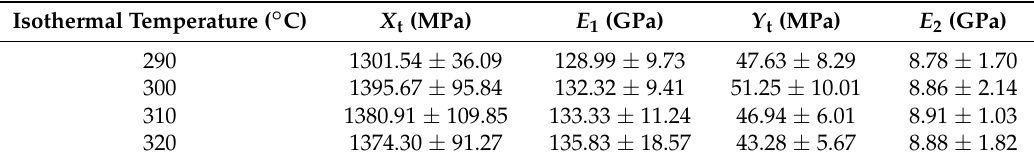
Table 1. Longitudinal and transverse tensile properties of CF/PEEK unidirectional plates at different isothermal temperatures. ( X t is the longitudinal tensile strength; E 1 is the longitudinal tensile modulus; Y t is the transverse tensile strength; E 2 is the transverse tensile modulus).